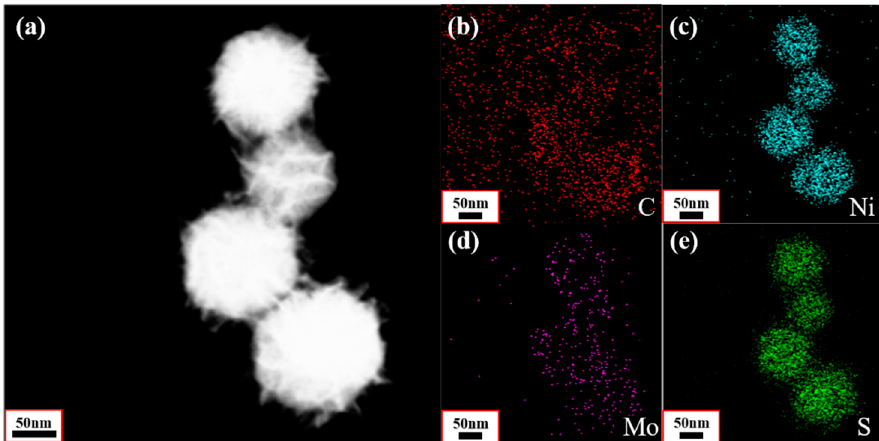
Figure 5. ( a ) TEM image and ( b–e ) EDS mapping images of NiS 2 @MoS 2 /rGO composites.